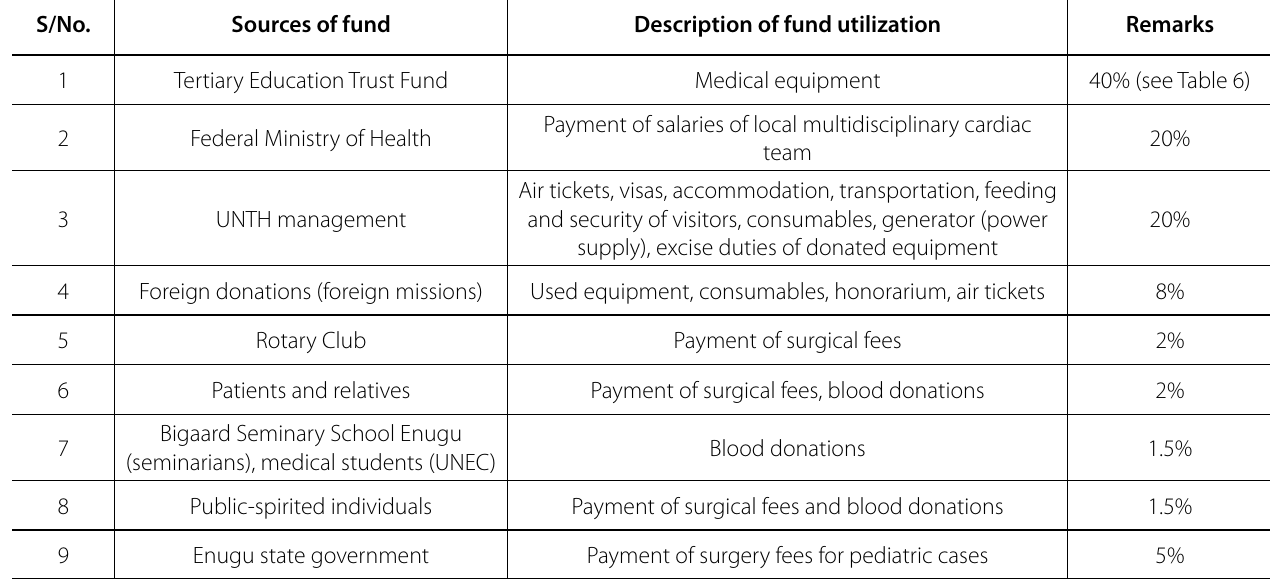
Table 5 . Funding of the open-heart surgery program at the National Cardiothoracic Center of Excellence, University of Nigeria Teaching Hospital (UNTH), Enugu.